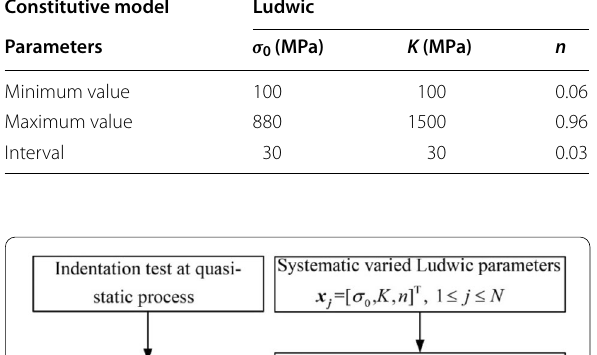
Table 1 Possible range of parameter vector x j for the database Constitutive model